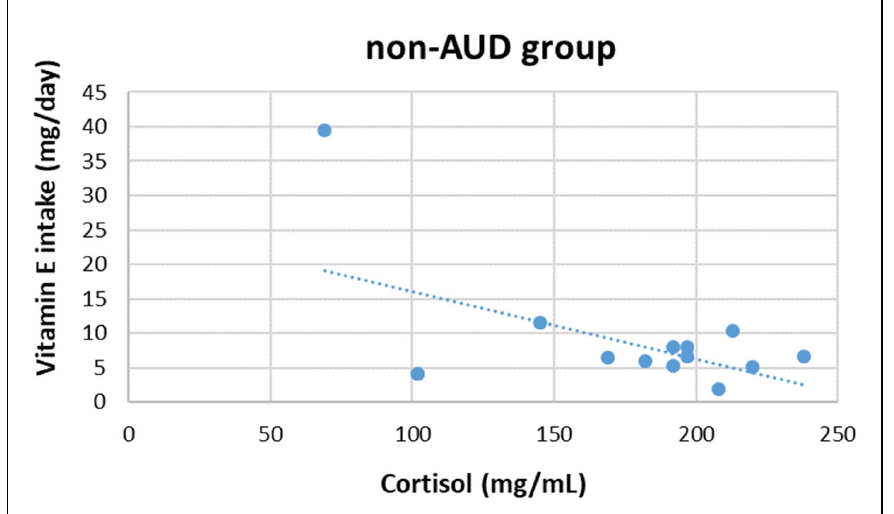
Figure 4. Correlation between plasma cortisol concentrations and daily vitamin E intake in non ‐ AUD group.